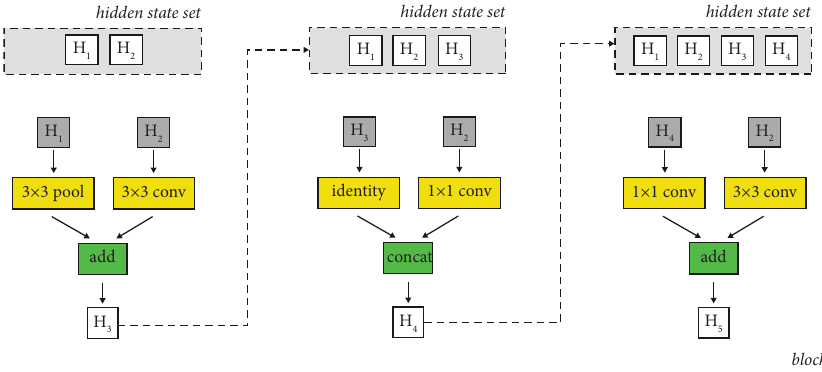
Figure 8: NASNetMobile architecture.